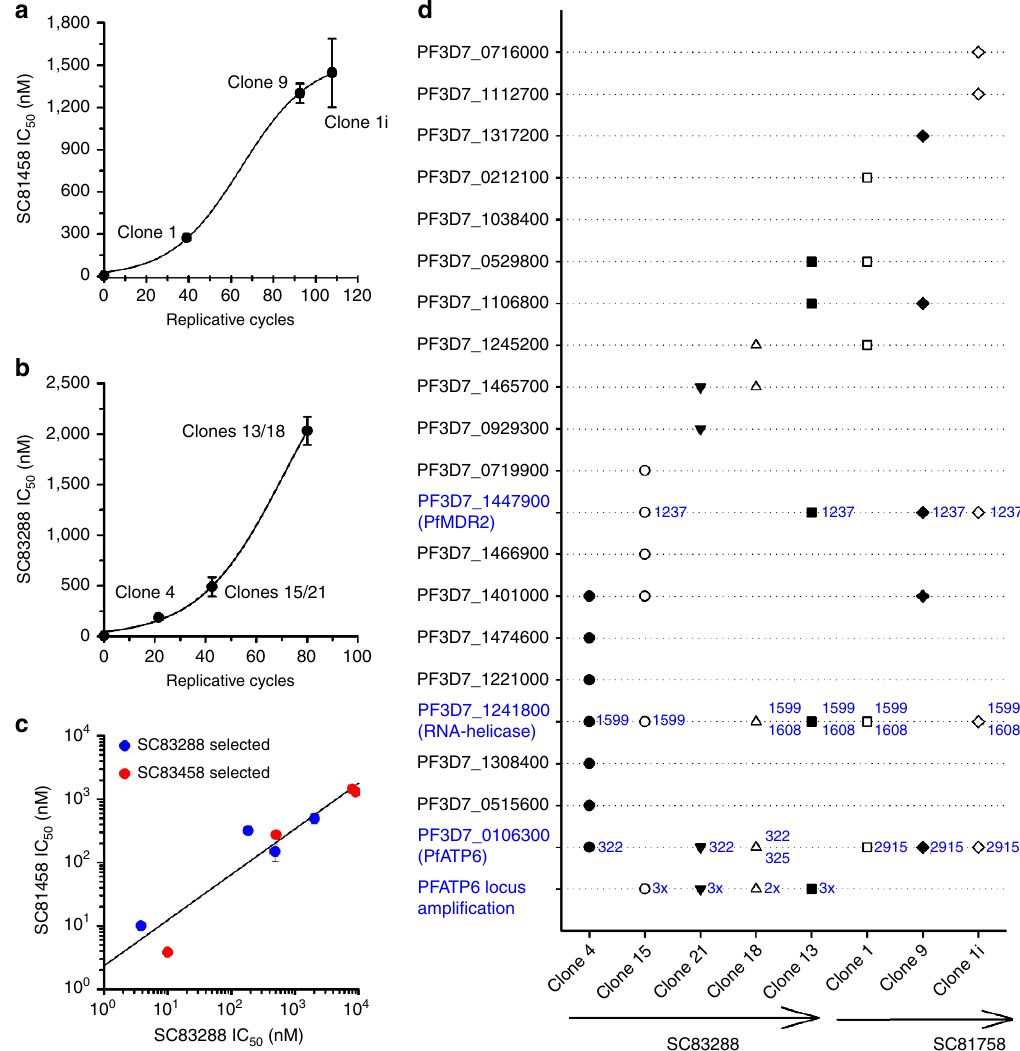
Figure 8 | In vitro generation of SC81458 and SC83288-resistant P. falciparum clones. ( a , b ) B 10 10 infected erythrocytes were treated with increasing concentration of SC81458 ( a ) or SC83288 ( b ) and the decrease in drug susceptibility was monitored over time. Clones obtained at different time points during selection are indicated. The means ± s.e.m. of at least three independent determinations are shown. ( c ) Cross resistance between SC81458- and SC83288-selected clones. ( d ) Identified single-nucleotide polymorphisms (SNPs) and gene amplifications in the genome of resistant clones. The arrows point in the direction of increased selective pressure. SNPs and gene amplifications associated with resistance to SC compounds are highlighted in blue. This includes PfMDR2 (position 1237), a putative ATP-dependent RNA helicase DBP9 (position 533) and PfATP6 (position 322 and 325), as well as an amplification of the PfATP6